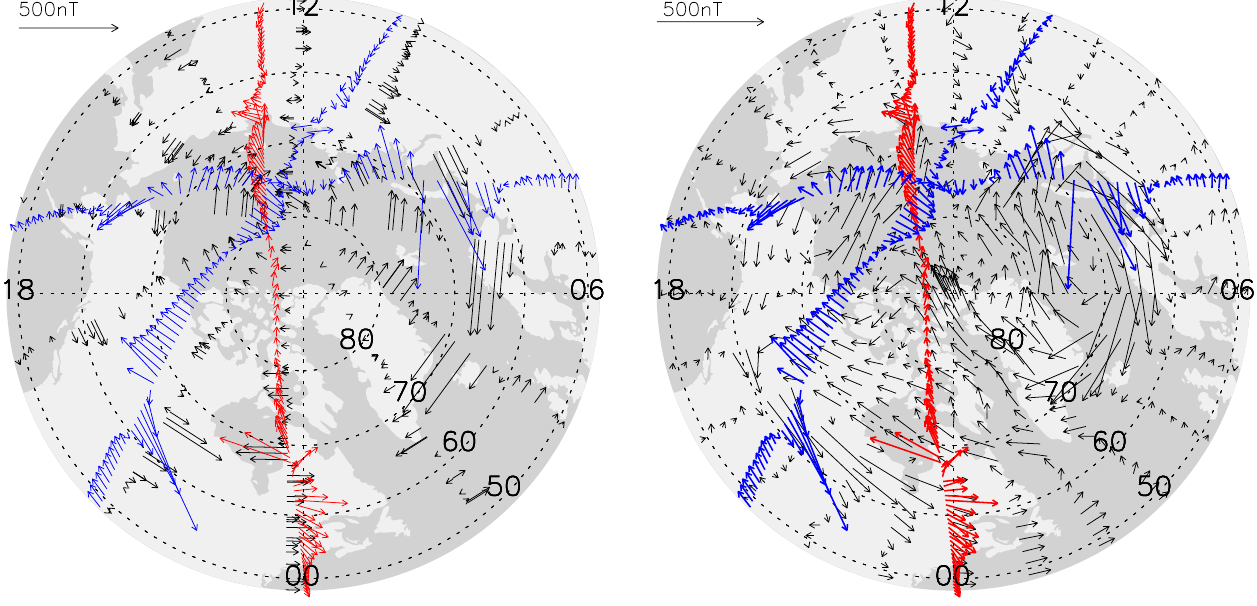
Fig. 4. Cross-track component of the Iridium 4 b data (black) for 1 November 2001, 03:30–04:30 UT. The two blue tracks are full vector 4 b observations from DMSP satellite F13 (17:00– 07:00 MLT track) and F15 for 03:28–03:57 UT and 03:51– 04:22 UT, respectively. The red track shows full vector 4 b ob- servations from the Oersted satellite for 0339-0408 UT. Latitudinal coordinates are in the AACGM system.